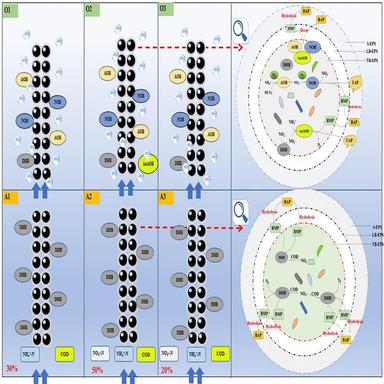
Mechanism of advanced nitrogen removal.